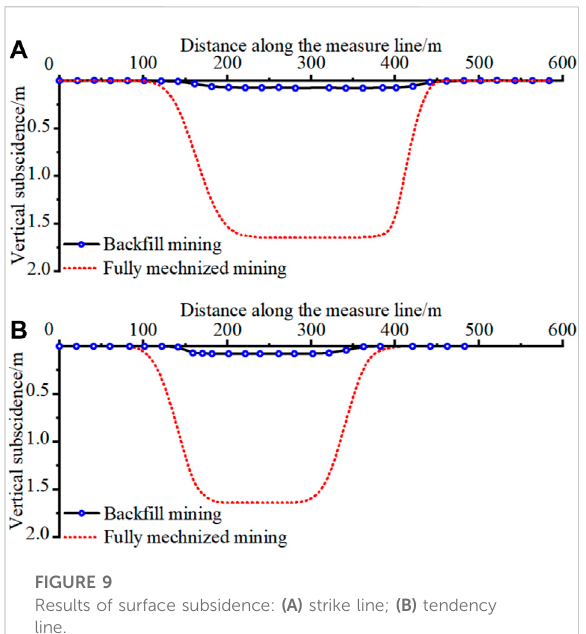
FIGURE 9 Results of surface subsidence: (A) strike line; (B) tendency